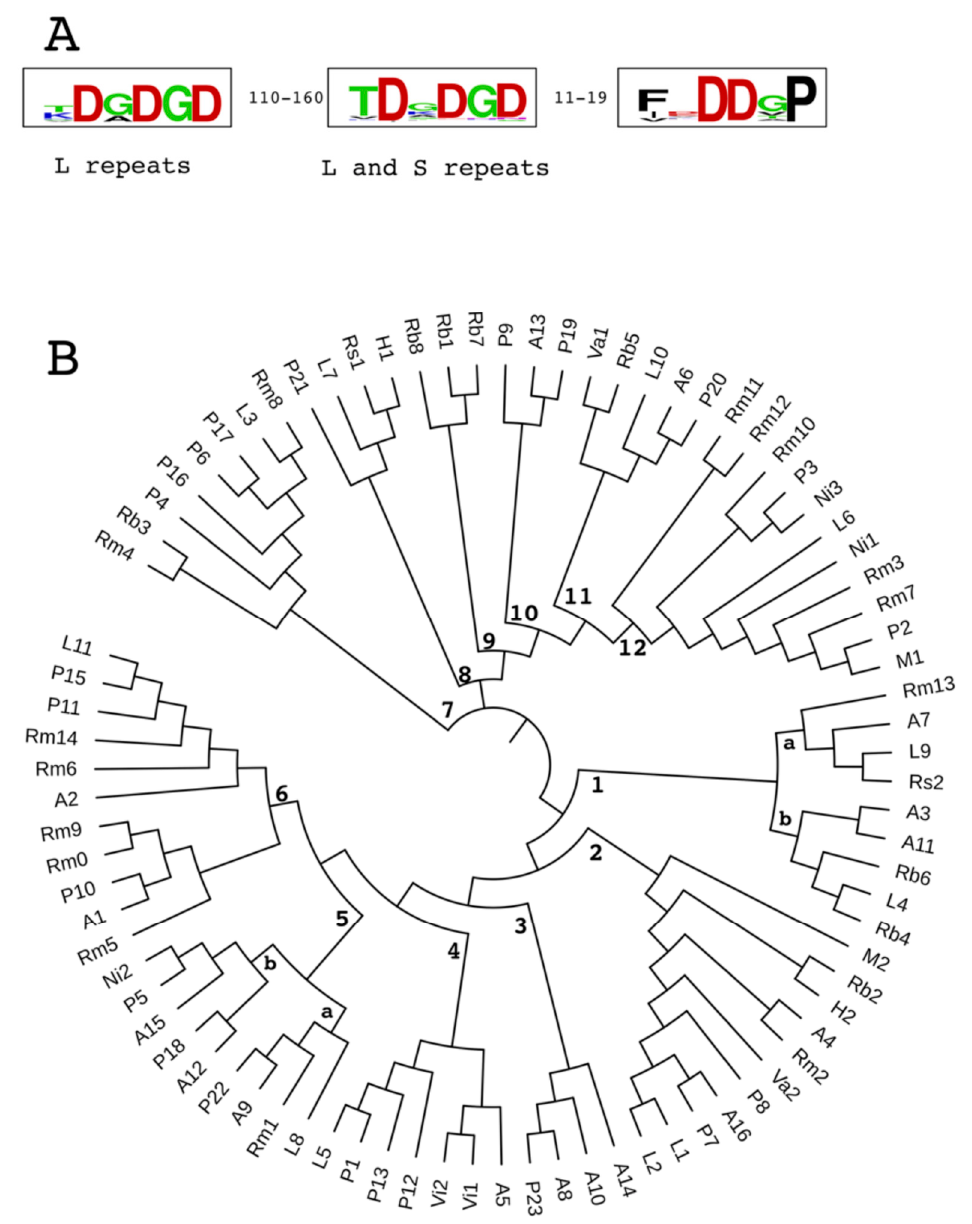
Figure 4. DDxP repeats. ( A ) Signatures of repeats. Conserved sequence motifs in short (S) and long (L) repeats are highlighted by WebLogo alignments. The number of amino acids between repeat motifs is shown. ( B ) Phylogenetic tree. The 85 DDxP repeats described in this work were aligned in a circular tree at the Interactive Tree Of Life (iTOL) site (https://itol.embl.de.).